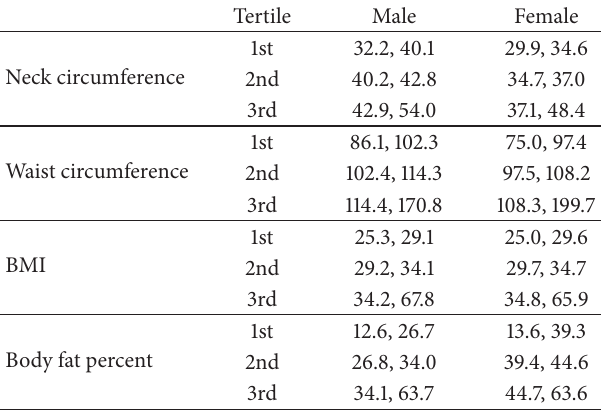
Table 4: Ranges for tertiles of anthropometric